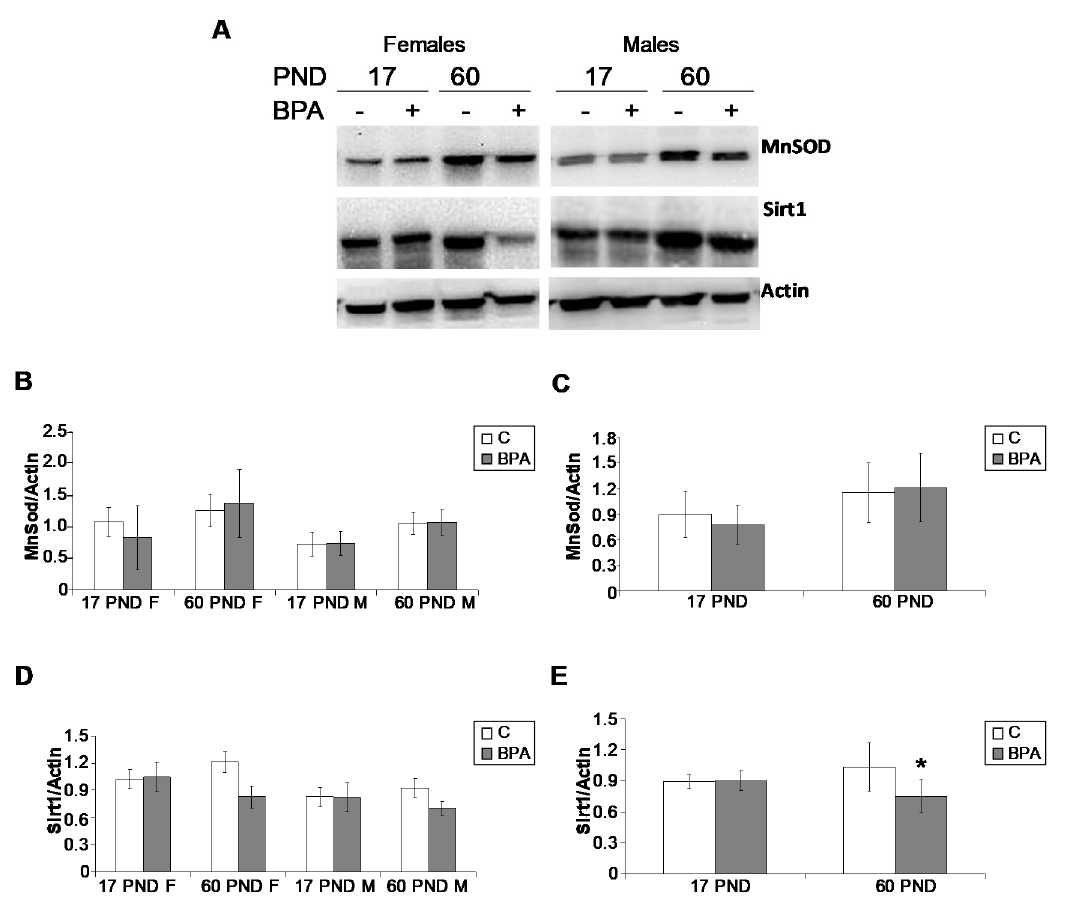
Figure 4. Representative Western blot for MnSOD and Sirt1 carried out in liver samples collected from lactating and young animals. ( A ). Data were normalised against actin– β , and are reported in ( B – E ) as mean value ± SD ( n = 3 in B and D, n = 6 in C and E, 3 males and 3 females). F: females; M: males; PND: postnatal day. * p = 0.0143.